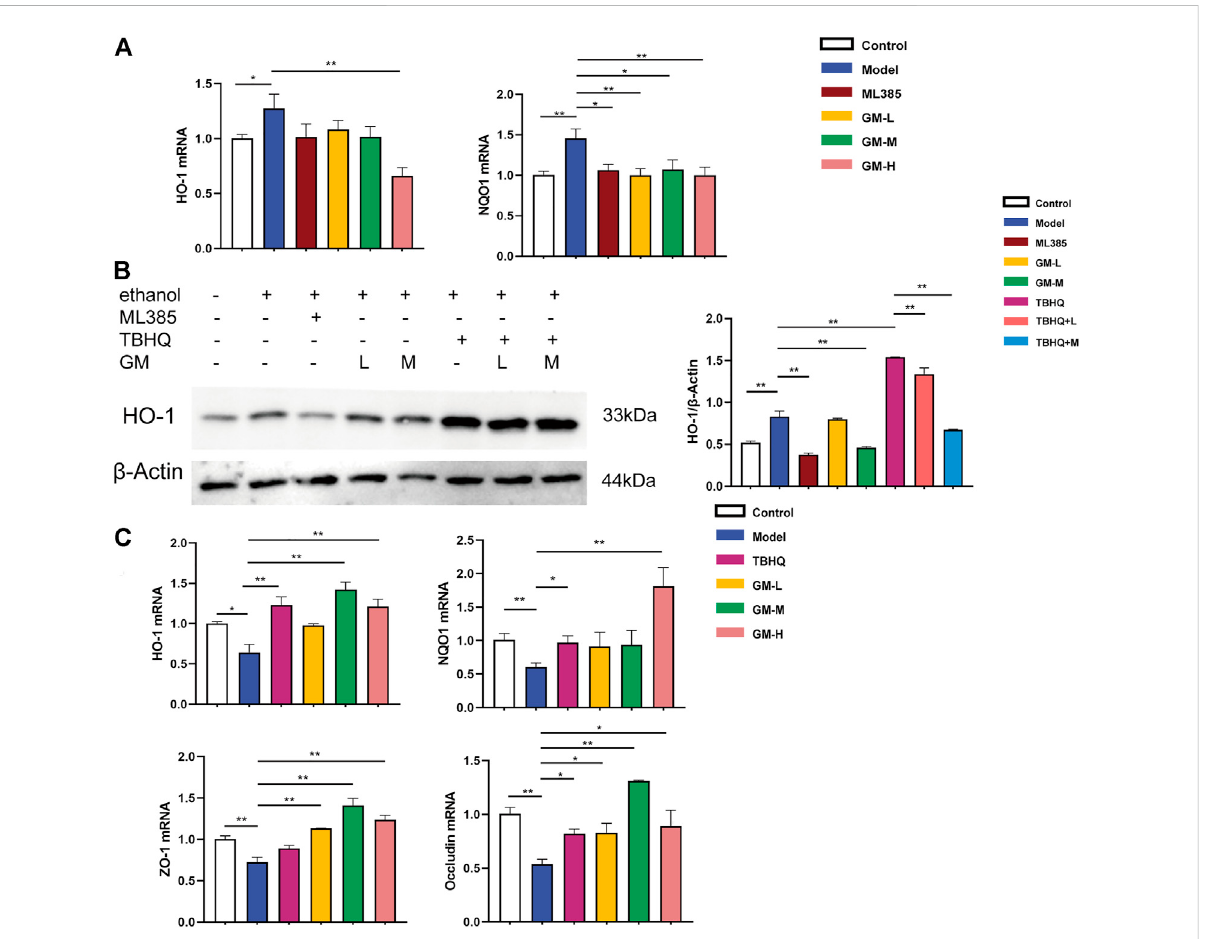
FIGURE 8 Protective effect of JGST against alcohol-induced liver injury in HepG2 and IEC-6 involved modulation of Nrf2. (A) mRNA expression of HO-1 and NQO1 in Hepg2. (B) The protein expression of HO-1 in HepG2. (C) mRNA expression of HO-I, NQOI, ZO-I&Occludin in IEC-6. Data were presented as Mean ± SEM, * p < 0.05, **. p . < 0.01, *** p < 0.001, n =